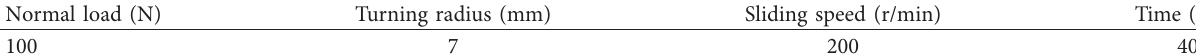
Table 3: Rotary wear test parameter.